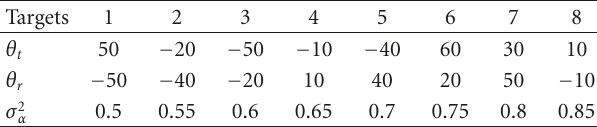
Table 3: Locations of the eight